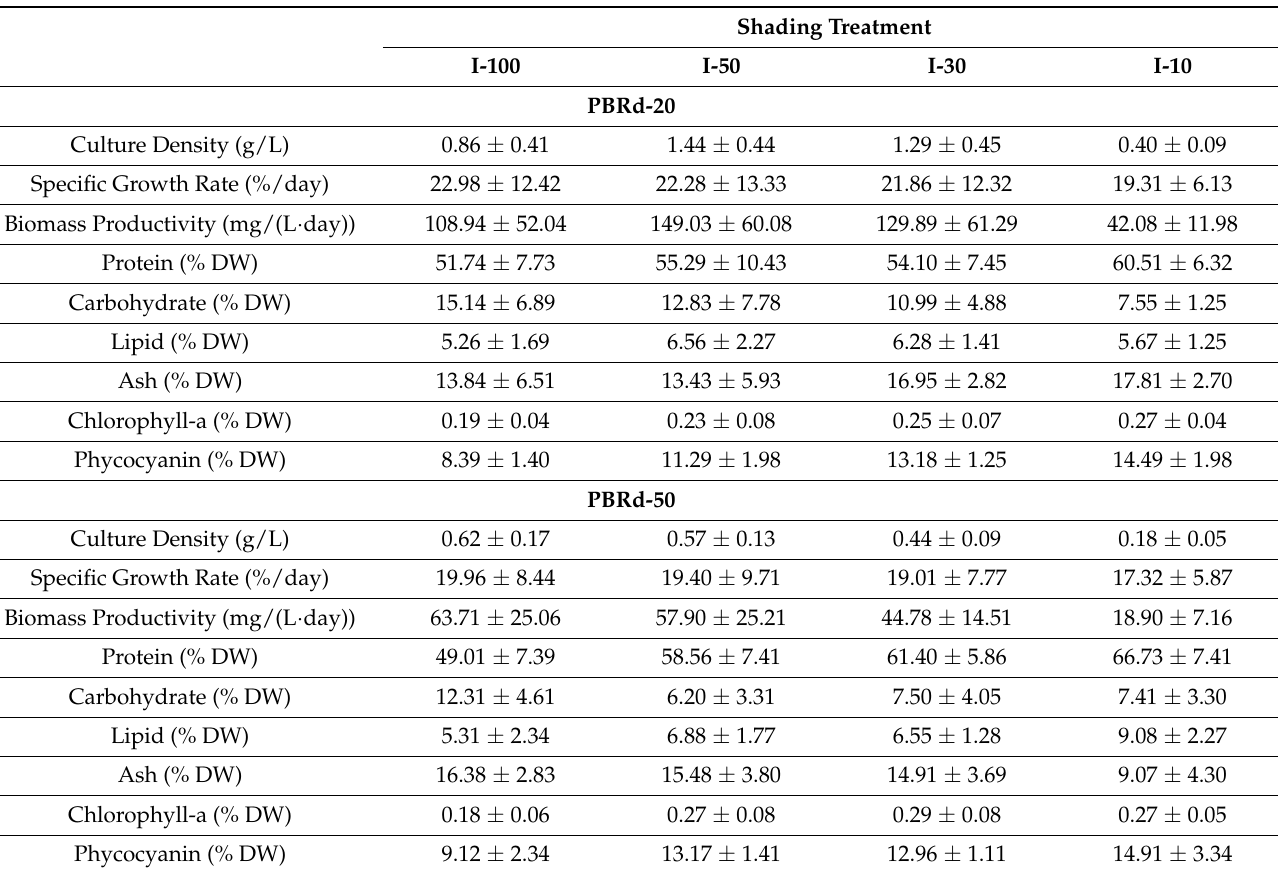
Table 1. Growth performance and biochemicals content of A. platensis in outdoor inclined plastic column